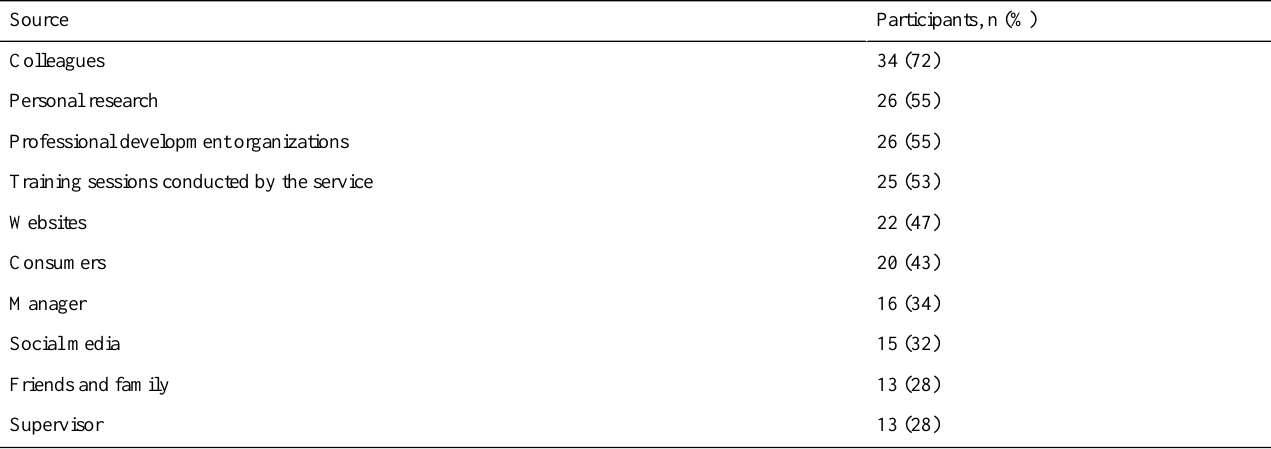
Table 3. Participants’(n=47) sources of learning about technologies for mental health